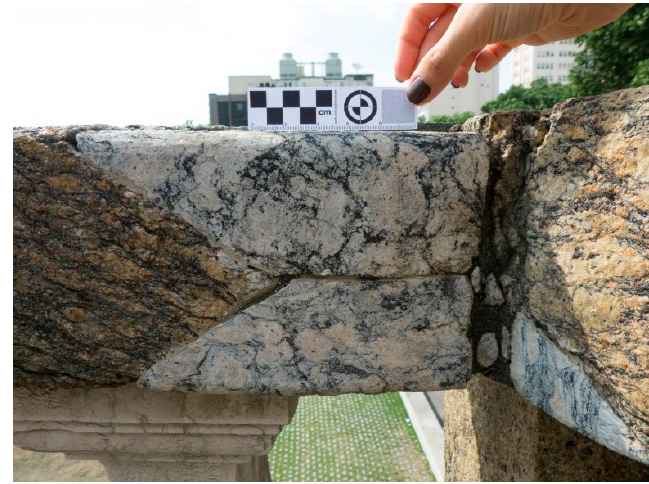
Figure 8. Substitute piece on a Gneiss block.